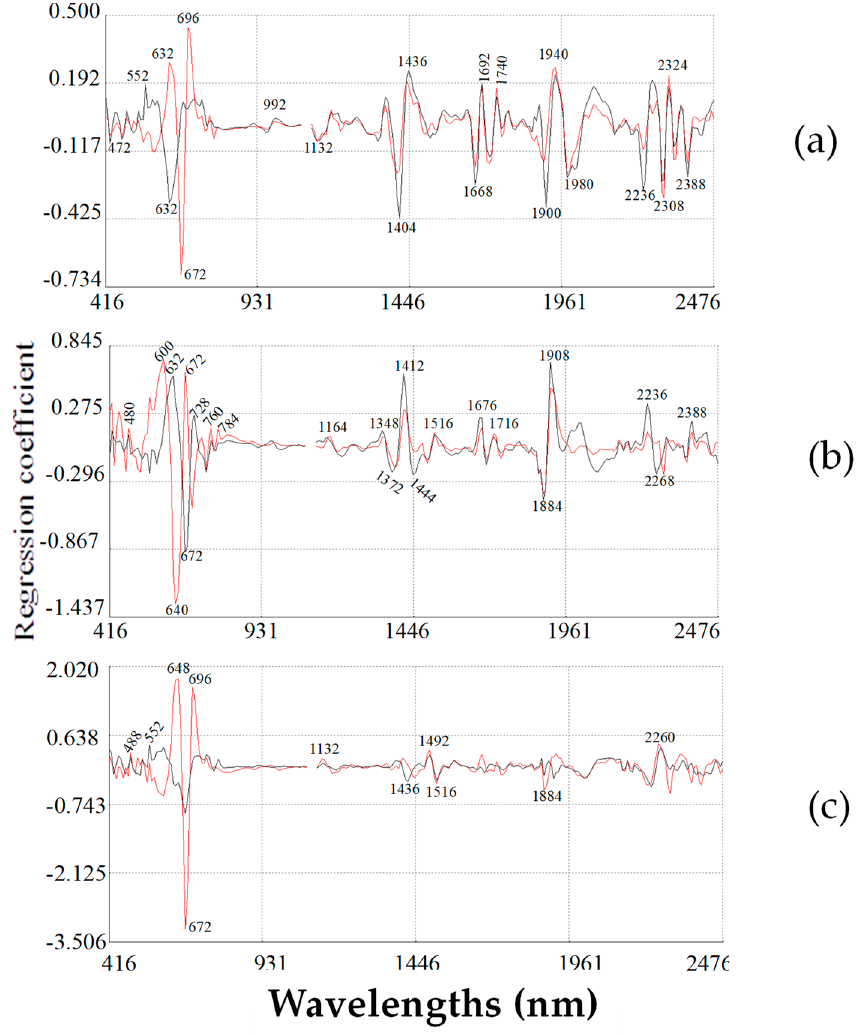
Figure 5. MPLS loading plots for TPC (black line) and TCC (red line) using near-infrared reflectance spectroscopy. ( a ) First loading; ( b ) Second loading; ( c ) Third loading.